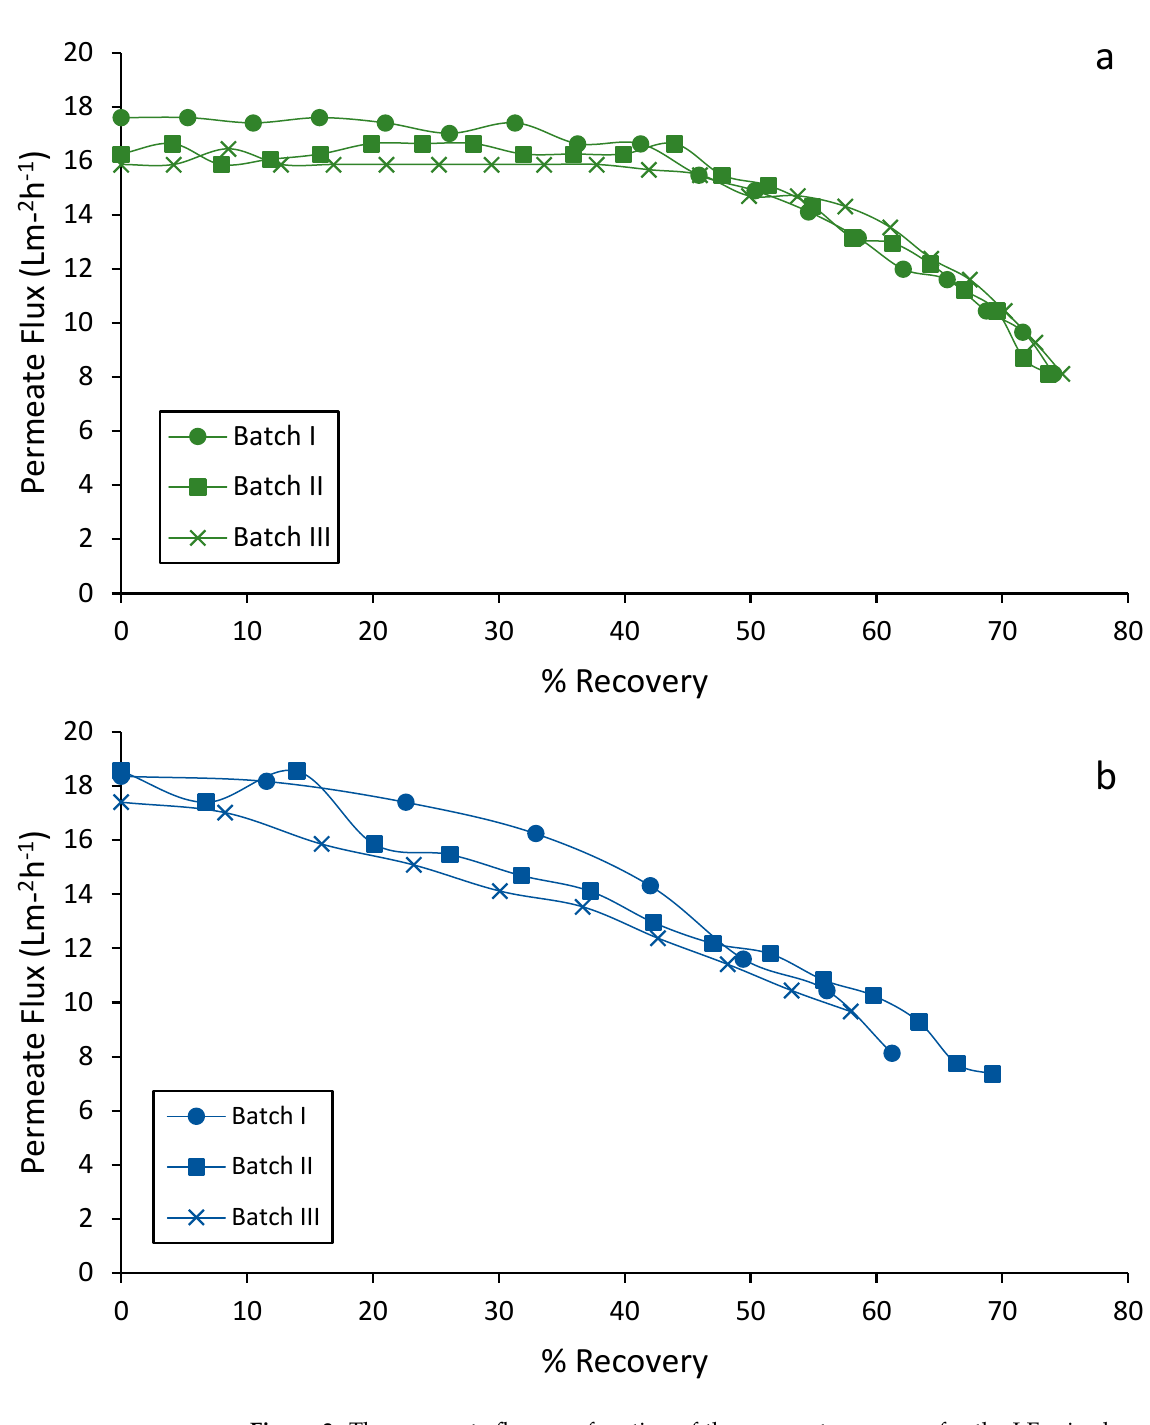
Figure 3. The permeate flux as a function of the permeate recovery for the LF- pig slurry ( a ) and LF-digestate ( b ) tested in the screening